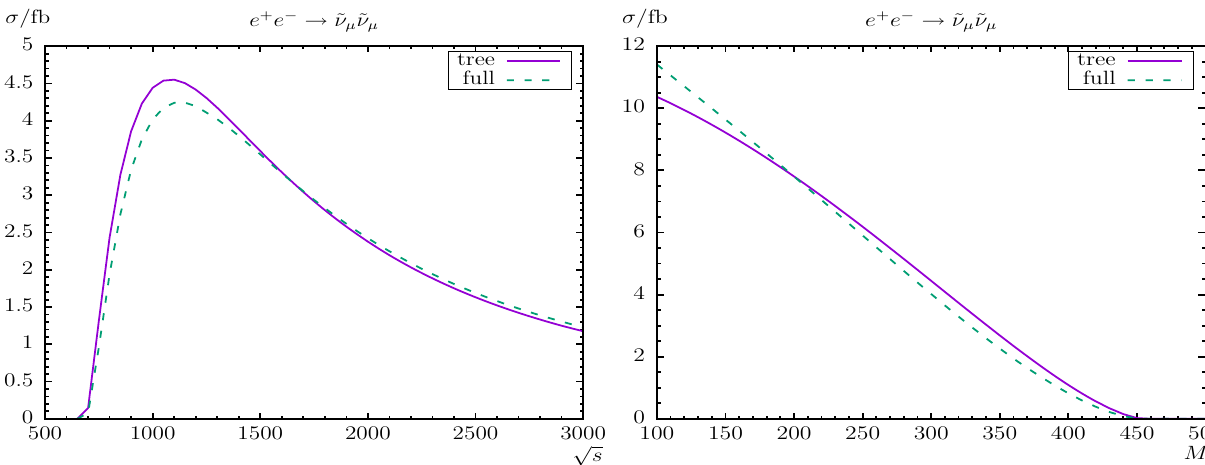
Fig. 18 σ( e + e − → ˜ ν e ˜ ν ∗ e ) . Tree-level and full one-loop corrected cross sections are shown with parameters chosen according to S ; see Table 1. The upper plots show the cross sections with energies are in GeV